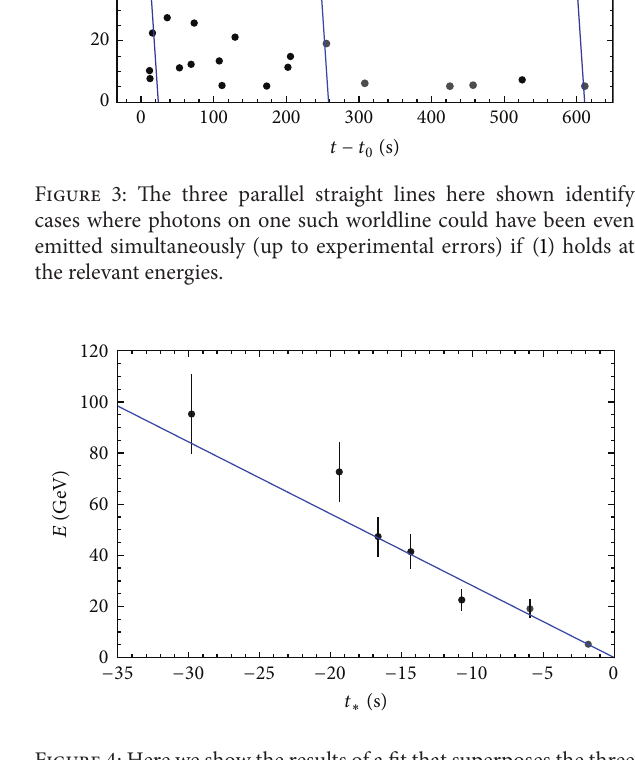
Figure 4: Here we show the results of a fit that superposes the three parallel lines in Figure 3. The seven points here shown are the ones on those parallel lines of Figure